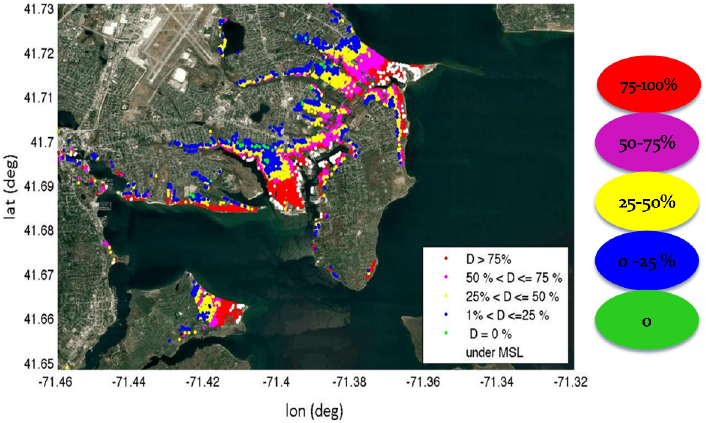
Figure 19. Percent damage by structure for Warwick, RI for 100 year event plus 2.1 m (7 ft) SLR. Structures that are below MSL are noted by white dots and those removed by erosion are given by black dots.